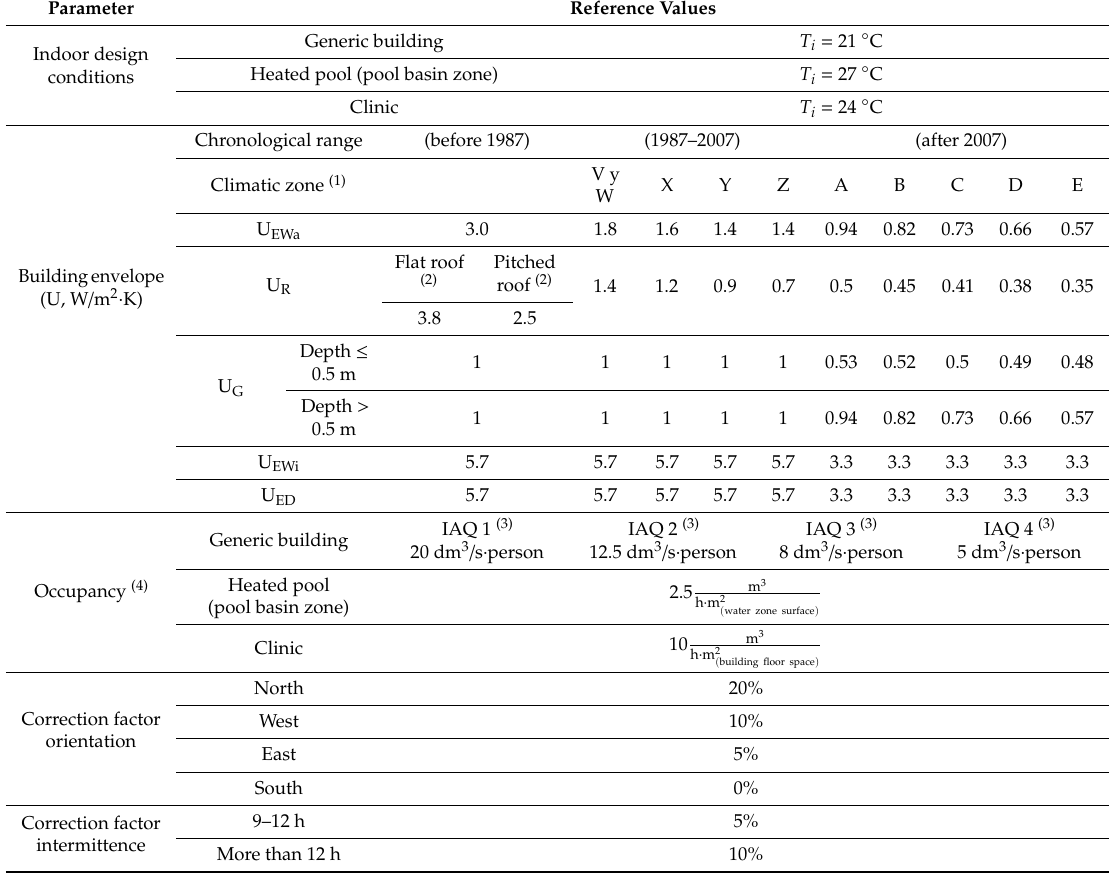
Table A2. Reference values of the di ff erent parameters of the heating model.